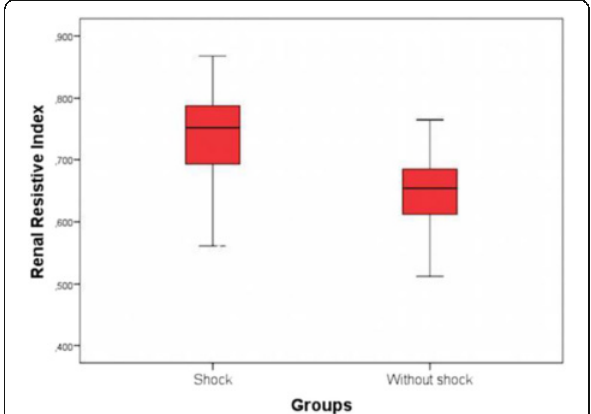
Fig. 41 (abstract A104). Boxplot of the distribution of the